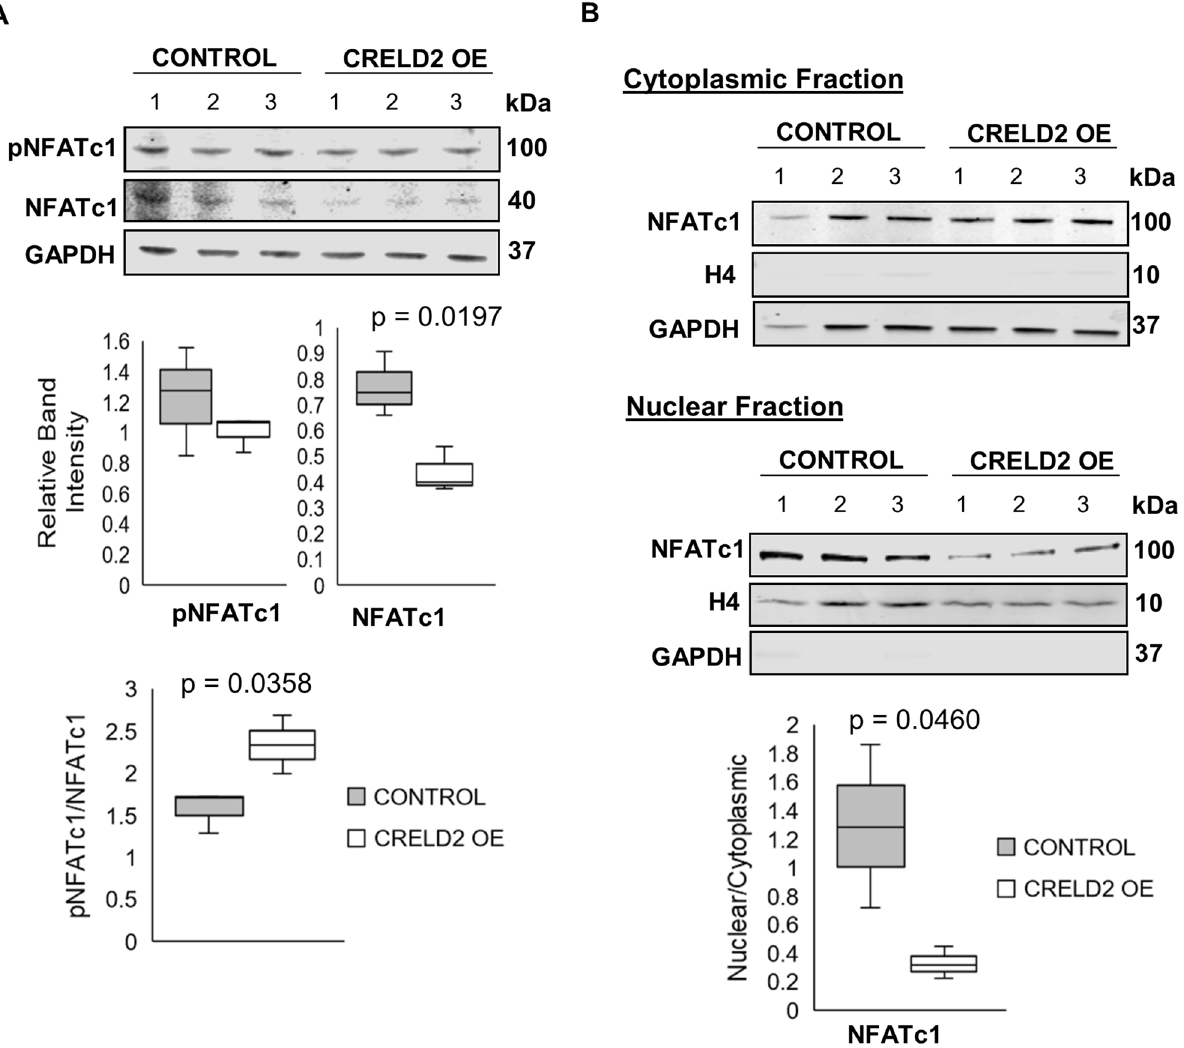
Figure 4. CRELD2 overexpression disrupts NFATc1 nuclear translocation during osteoclastogenesis. ( A ) Western blot of phospho-NFATc1 (pNFATc1) and total NFATc1 expression in Control and CRELD2 OE osteoclasts 24 h after rRANKL stimulation. Equal loading shown by GAPDH. Levels were determined by band densitometry. ( B ) Western blot showing the cytoplasmic/nuclear localisation of NFATc1 in Control and CRELD2 OE osteoclasts 24 h after rRANKL stimulation. GAPDH and Histone H4 (H4) were used as markers of the cytoplasmic and nuclear fractions respectively. Equal loading shown by GAPDH. Levels were determined by band densitometry. n = 3 per sample. Graphs displayed as mean ± SD, significance denoted by p ≤